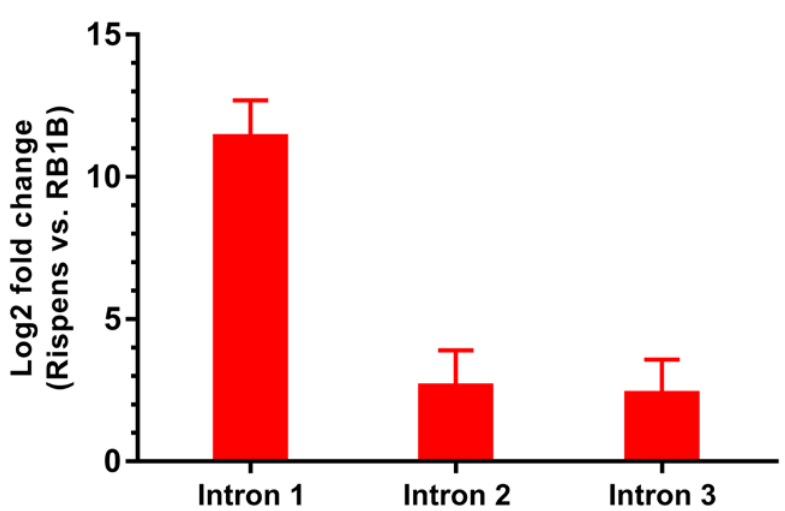
Figure 7. Differential expression in CEF cells of introns I1-I3 in CVI-988- and RB-1B-infected CEF cells. Different expression levels of introns I1, I2, and I3 when CEF cells were infected with 500 PFU of MDV strain CVI-988 were compared with cells infected with RB-1B at 5 days post-infection. The ratio of the expressions in CVI-988 and RB-1B was computed for each intron using the ΔΔ C T method and GAPDH as a calibrator (see the Materials and Methods section ).